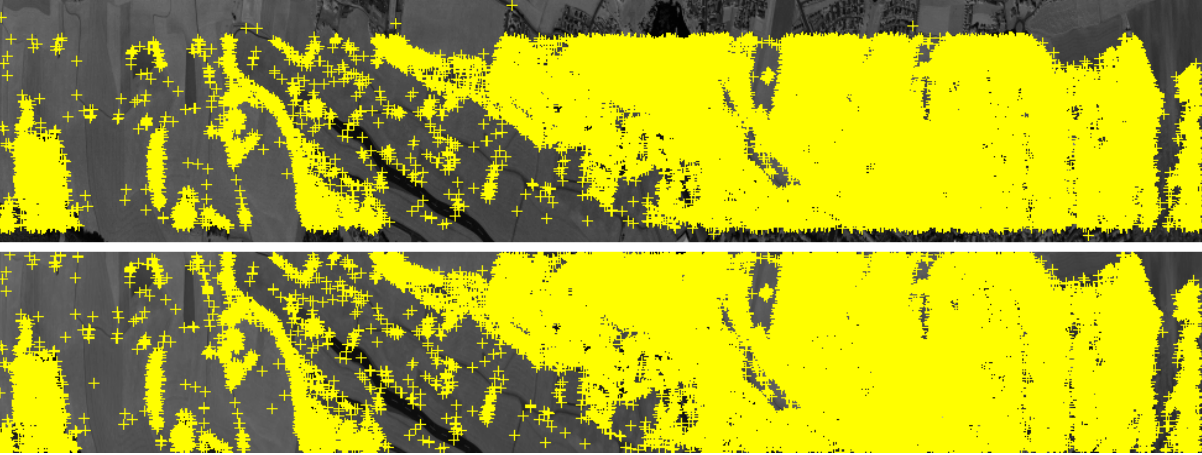
Figure 7: BRISK matches found in VNIR(top) and SWIR(bottom; scaled up)